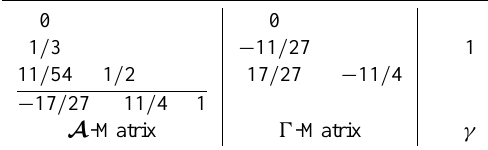
Table 3. Coefficient table for